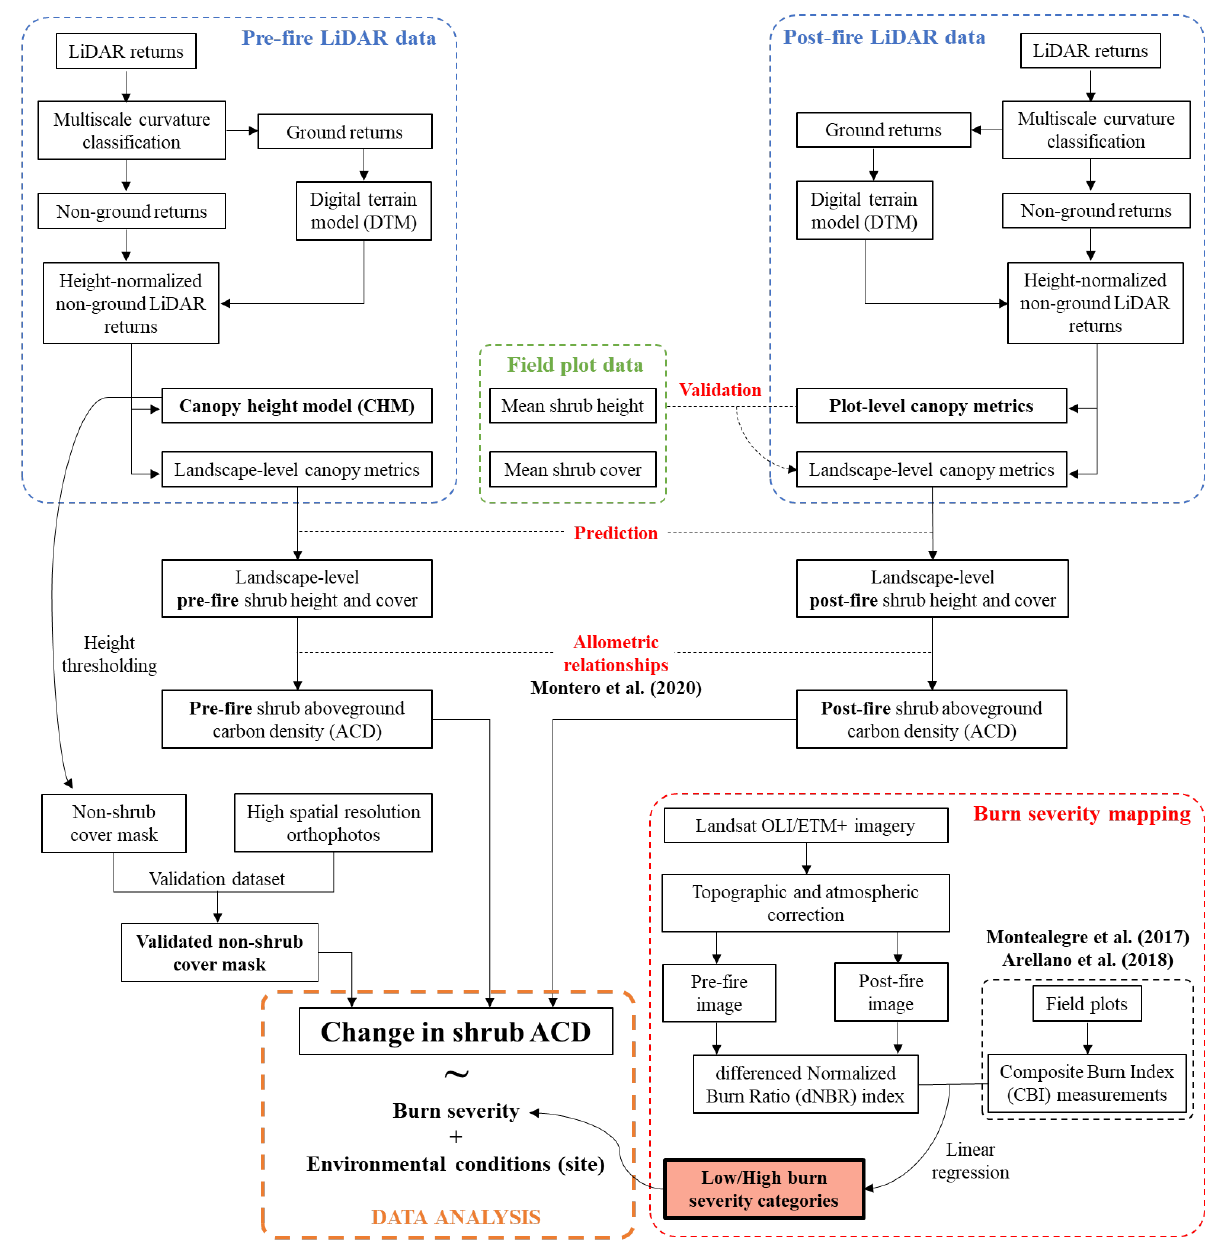
Figure 1. Methodology flowchart of the present study.